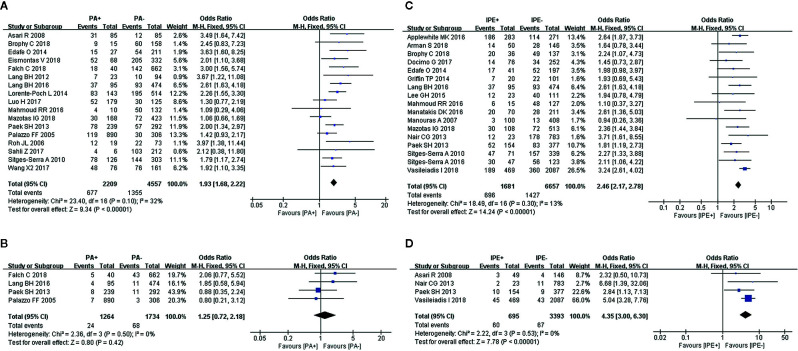
Meta-analysis results for the incidence of hypocalcemia between the two groups; (A) PA for transient hypocalcemia; (B) PA for permanent hypocalcemia; (C) IPE for transient hypocalcemia; and (D) IPE for permanent hypocalcemia.